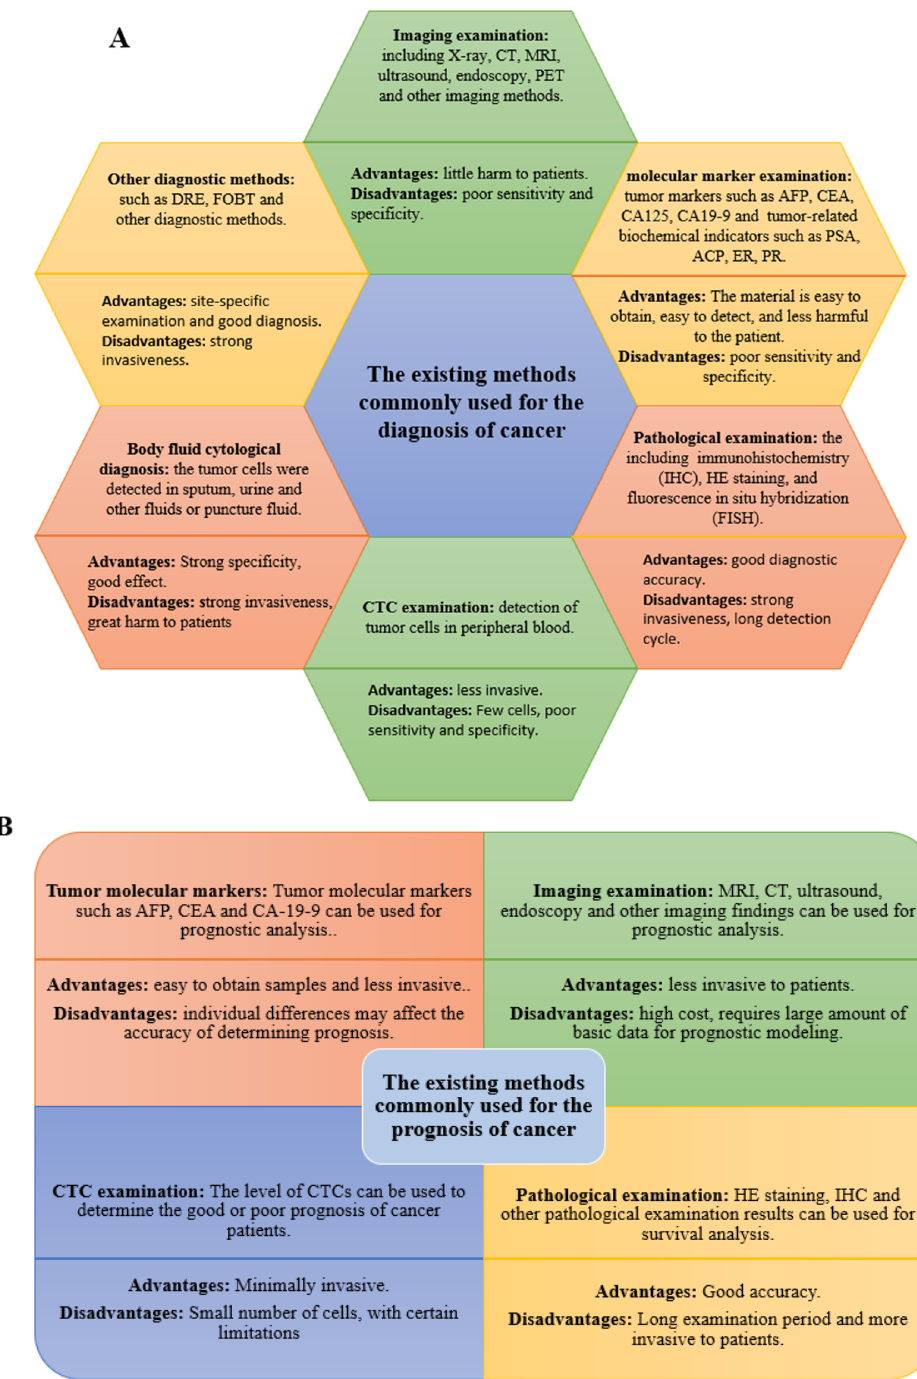
Figure 1. ( A ) The commonly used methods for the diagnosis of cancer. ( B ) The commonly used methods for the prognosis of